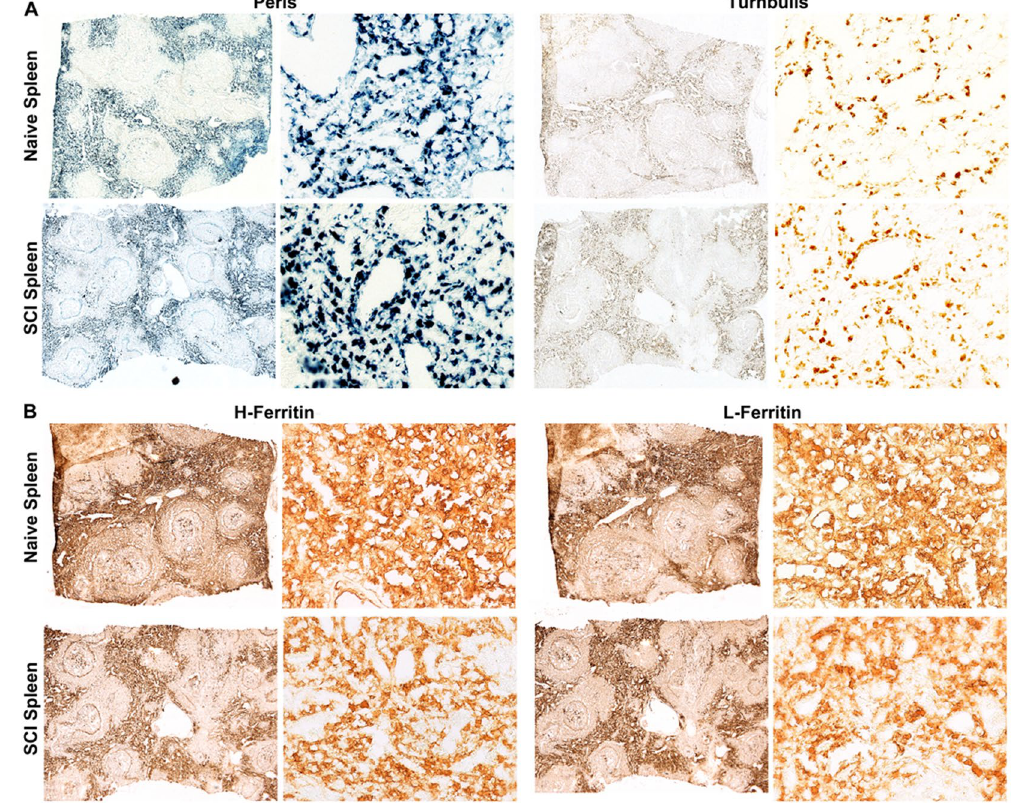
to Fe 2 + (Turnbull’s) stain in both naïve and SCI rats. ( B ) IHC for H and L ferritin shows no difference in ferritin expression between spleens from naïve vs. SCI